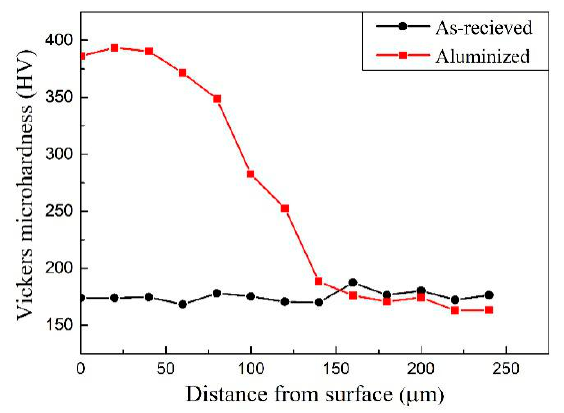
Figure 5. Microhardness variation along the depth of samples.